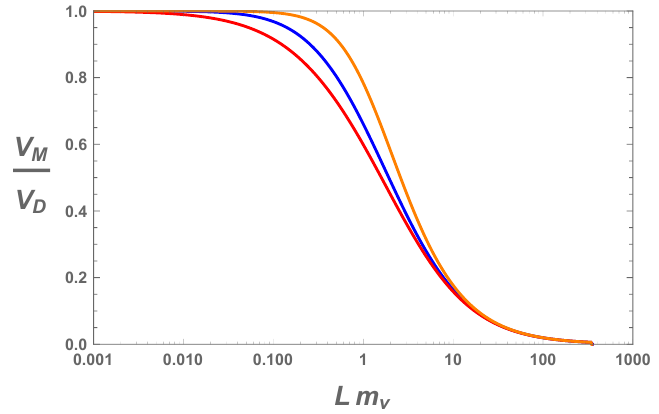
Figure 3 . Ratios of the Dirac and Majorana potentials for point-point (orange), plate-point (blue), and plate-plate (red) con(cid:12)gurations. Results are shown for equal masses ( m i = m j ). Majorana potentials are always weaker than Dirac potentials, consistent with prior results (e.g.